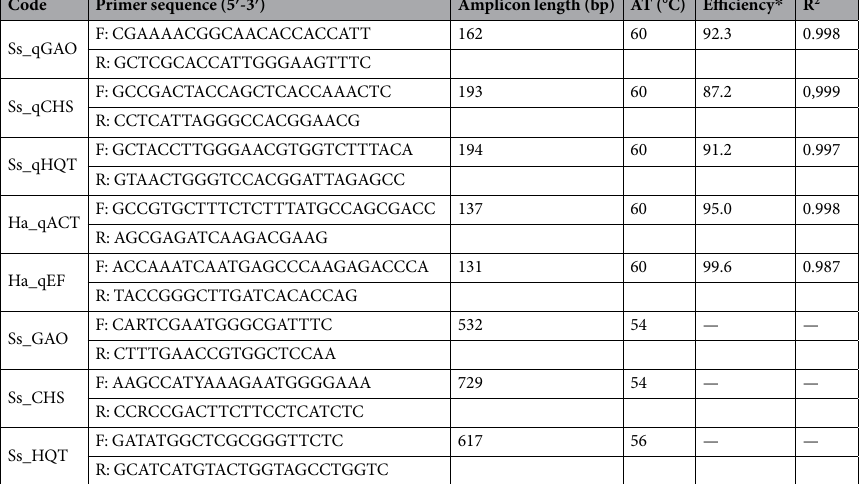
Table 1. Primer combinations used in PCR and qPCR. * Determined only for qPCR primers; AT: annealing